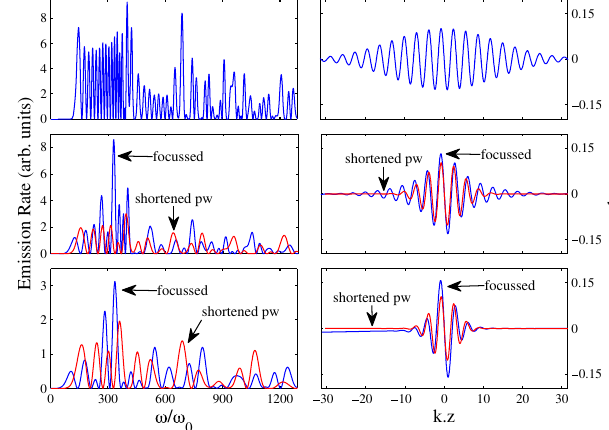
cycles.FIG. 11. Plots showing the total radiated power (Larmor power) in dimensionless units for fixed a 0 (a,b,c) and for fixed γ 0 (d,e,f) using the vector beam model (VBM) and the 1st and 5th order paraxial beam model (PBM). The relative % error in radiated power for the paraxial beam with respect to the vector beam model is presented in (g) and (h). The lines denoted by ( a 1 ) and ( f 1 ) are for the case of the 1st order paraxial beam, in all other cases there are no visible differences between the 1st and 5th order